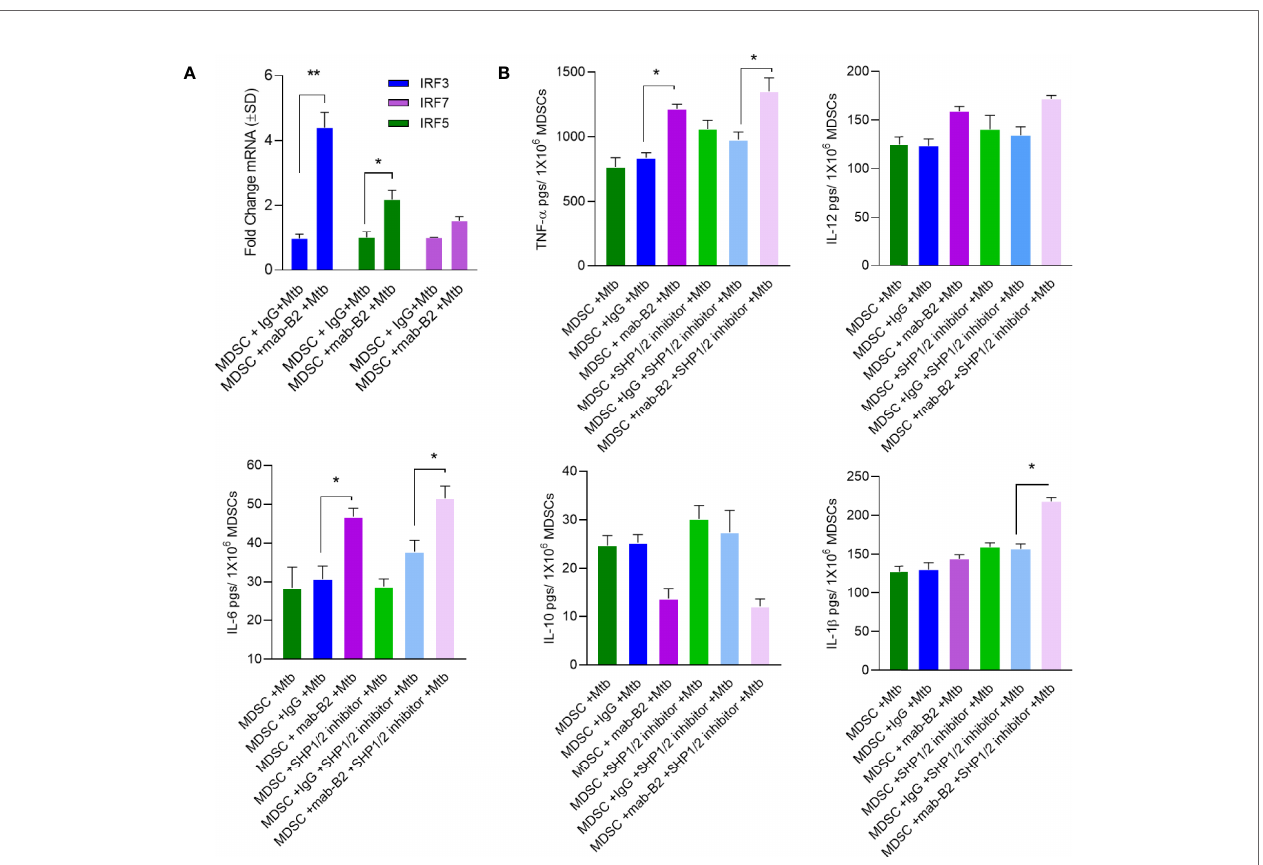
FIGURE 7 | LILRB2 antagonism enhances in fl ammatory cytokines in Mtb-infected MDSCs. CD14 + /CD33 + bead-puri fi ed M-MDSCs derived from GM-CSF/IL-6 cultured PBMCs from donors were infected for 4 h with Mtb H37Rv (MOI = 1), washed, and activated using either a monoclonal antibody to LILRB2 (mab-B2; 1 µg/ ml/10*6 cells) or its IgG isotype (1 µg/ml/10*6 cells) and SHP 1/2 inhibitors (1 µg/ml of each per 10*6 cells). Cells were lysed in trizol for qPCR and supernatants were tested for cytokines. (A) qPCR mRNA quantitation after mab-B2 or IgG treatment of Mtb-infected MDSCs at 18 h post infection (* p < 0.02 **, unpaired t -test). (B) Supernantants were collected at 18 h post infection and cytokines were assayed using sandwich ELISA (* p < 0.01 **, unpaired t